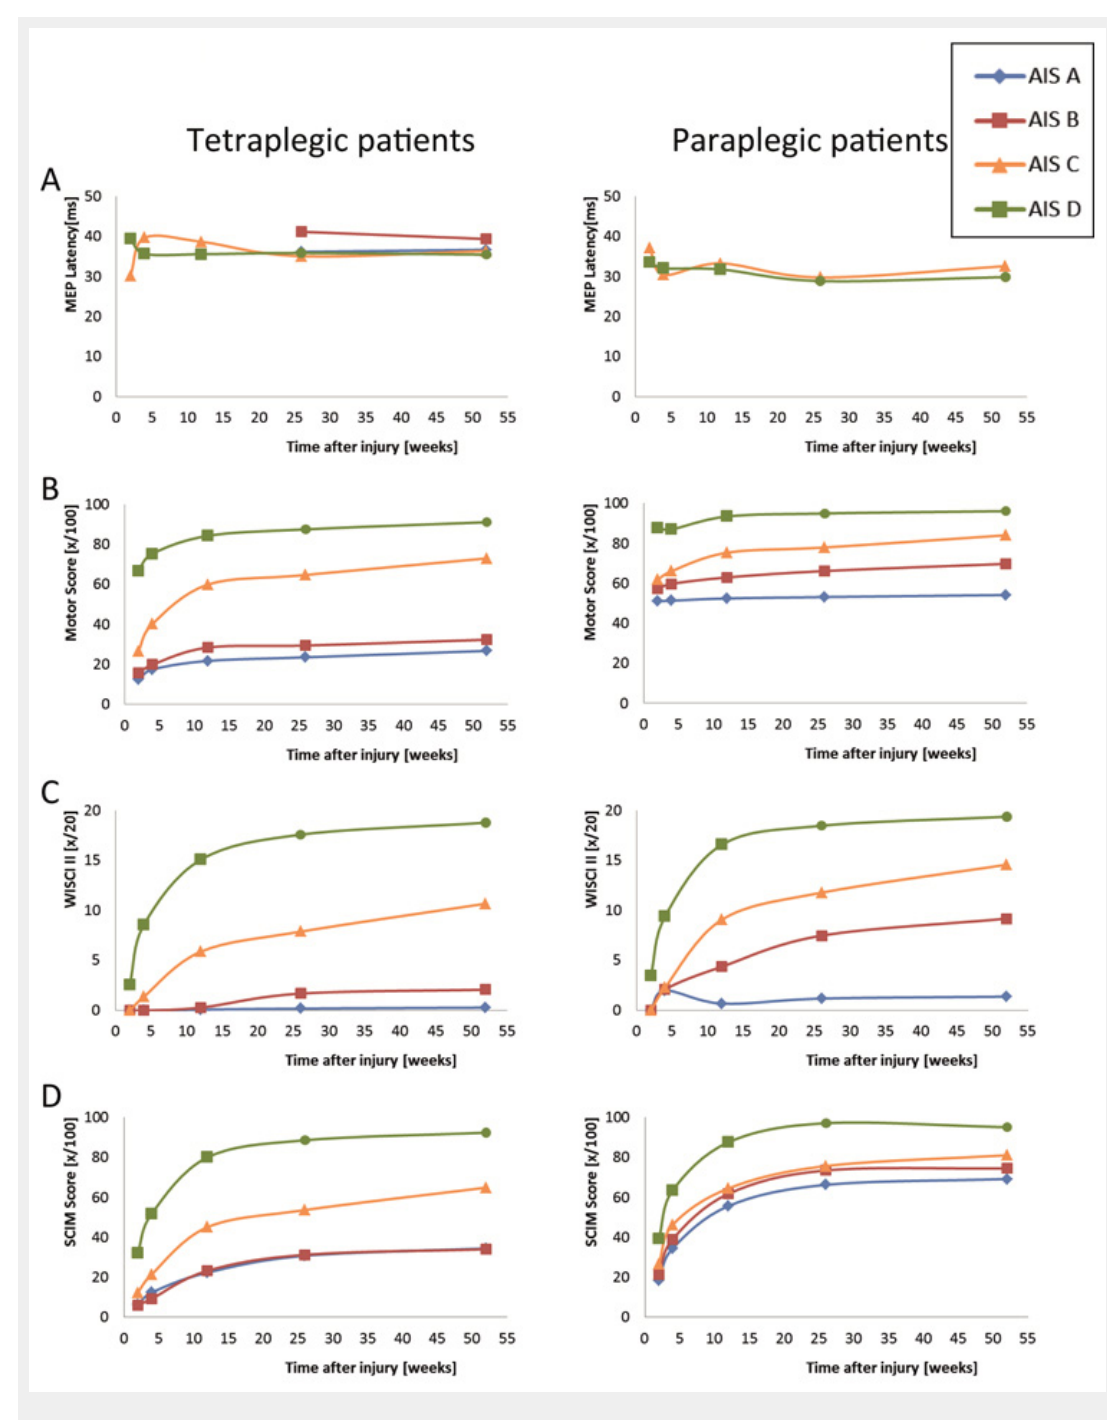
Improvement in motor functions and activities. Patterns of improvement in various motor functions and activities are shown for patient groups, which are categorised according to the level of lesion (tetraplegic versus paraplegic patients) and ASIA Impairment Scale (AIS). Patterns are shown of (A) the latency of motor evoked potentials (MEPs) evoked by transcranial magnetic stimulation, (B) the motor score of the key muscles according to the International Standards, (C) improvements in walking aids, braces and personal assistance as quantified with the revised Walking Index for Spinal Cord Injury (WISCI II) and (D) activities of daily living and independence as scored with the Spinal Cord Independence Measure (SCIM). (Numbers are based on